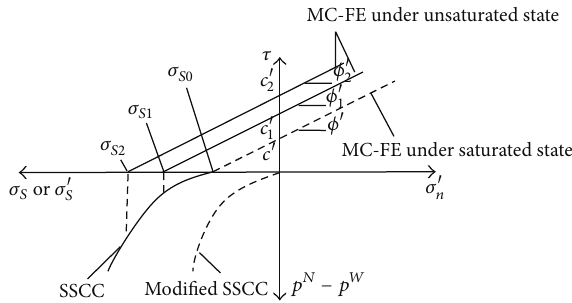
Figure 1: Suction stress characteristic curve from Mohr-Coulomb failure